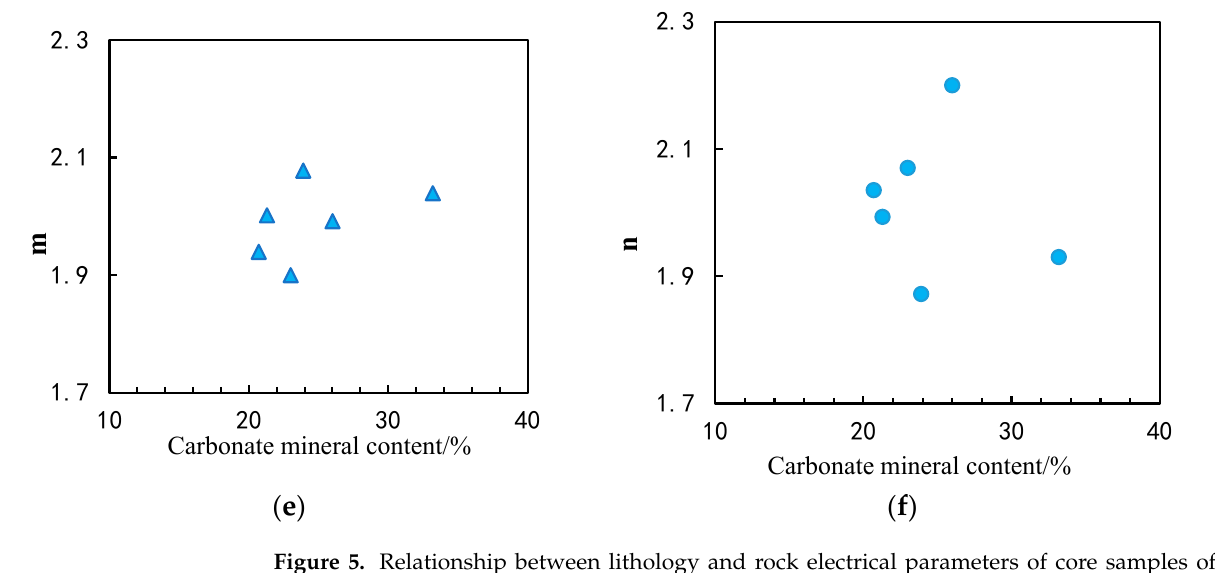
Figure 5. Relationship between lithology and rock electrical parameters of core samples of the Quaternary mudstone biogas reservoir. ( a ) Relationship between m and clay content. ( b ) Relationship between n and clay content. ( c ) Relationship between m and quartz content. ( d ) Relationship between n and quartz content. ( e ) Relationship between m and carbonate mineral content. ( f ) Relationship between n and carbonate mineral content.